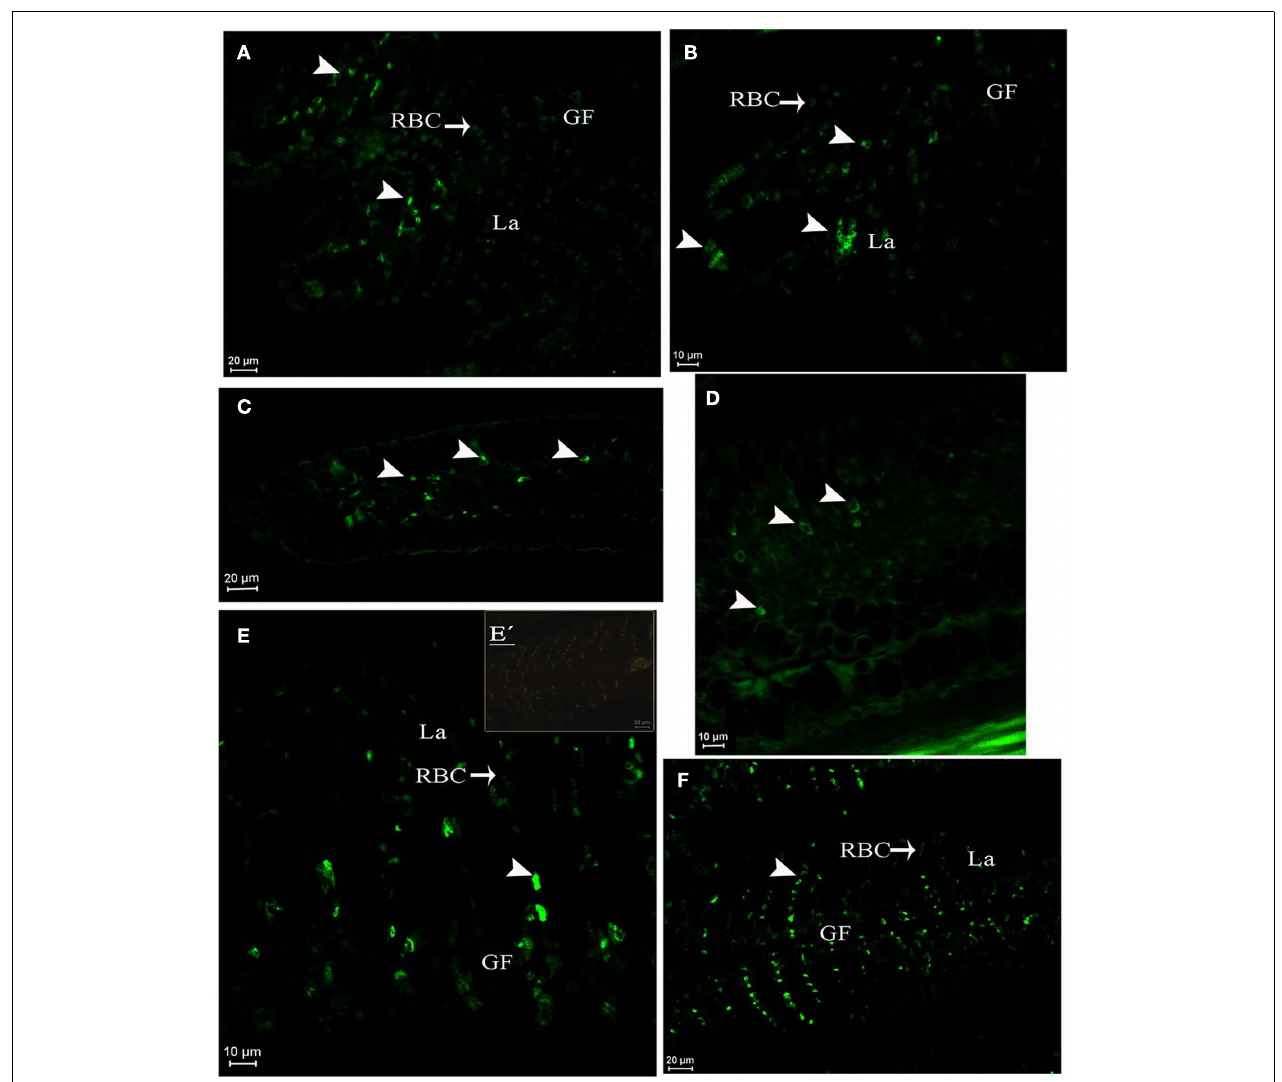
FIGURE 6 | Dicentrarchus labrax. AQP1a immunolocalization in juveniles at D96 in gill lamellae and filament (A,B) , esophagus (C,D) , and in pre-adult gill (E,E (cid:2) ,F) . Acclimation in SW (A,C,E,E (cid:2) ) , DSW (B,D) , or FW (F) .The presence of